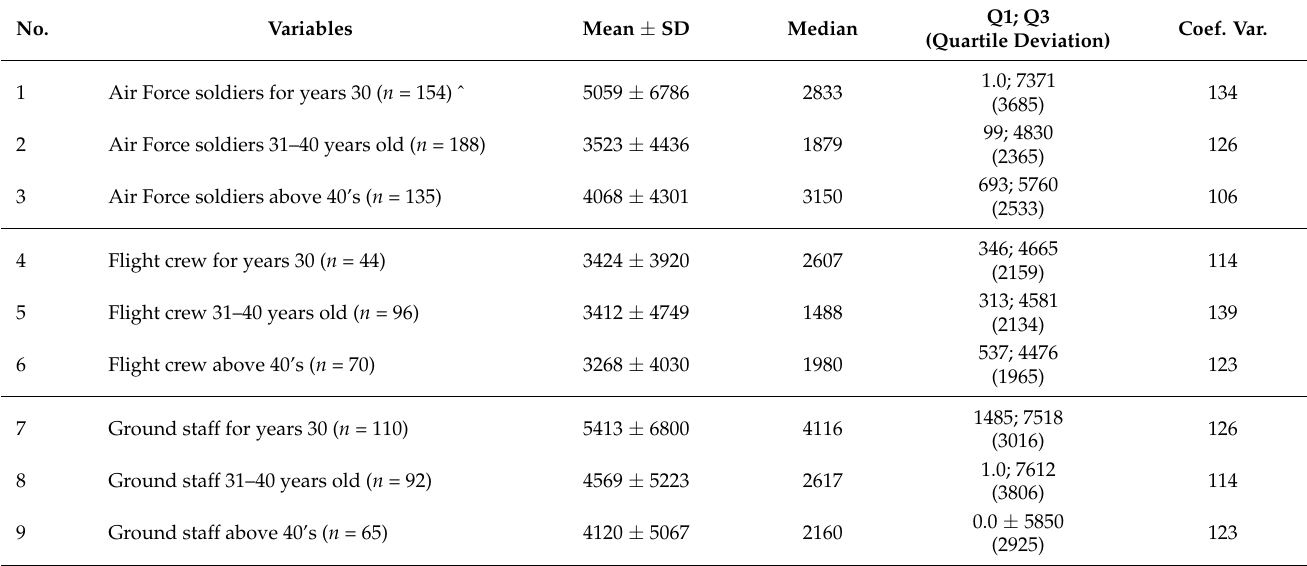
Table A2. Summary of total MET related to professional